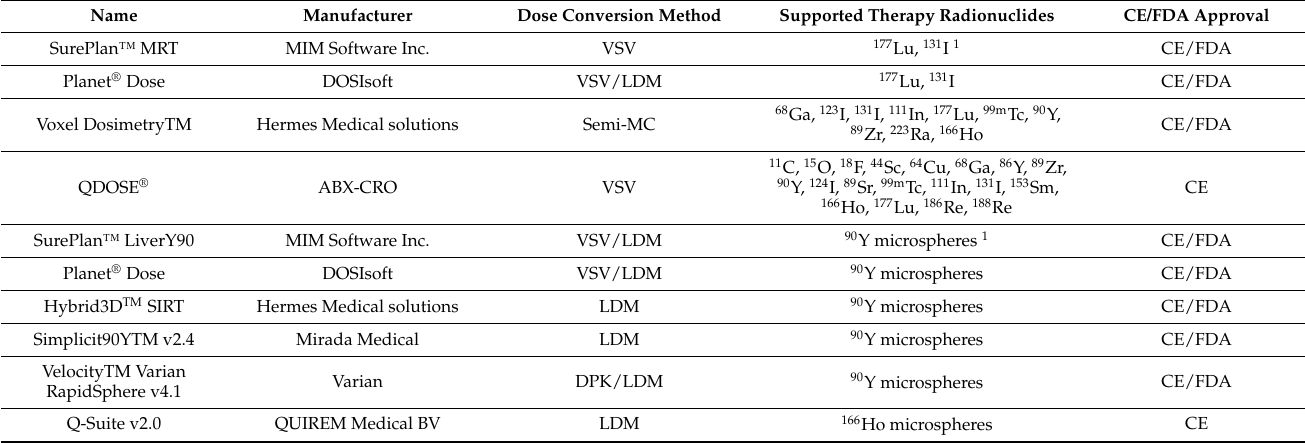
Table 5. Main commercial software packages for patient-specific